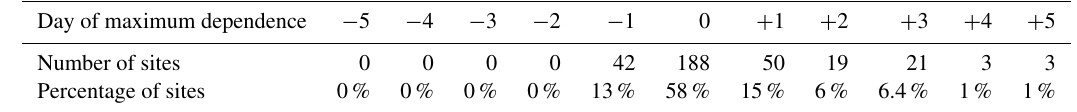
Table 2. Day of maximum dependence between high skew surges and river discharge in number of sites and percentage of sites. Day of maximum dependence